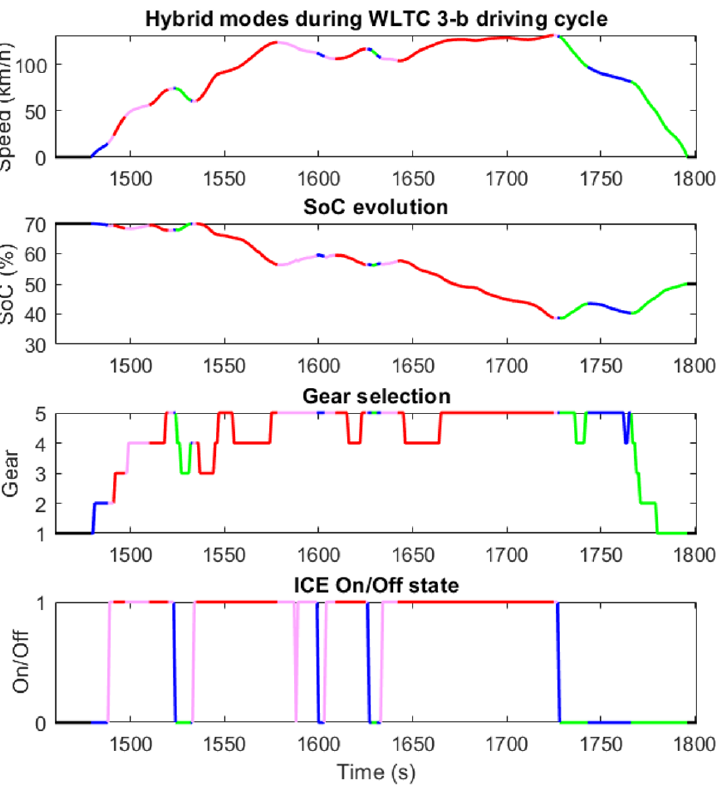
Figure 7. Optimal control results. Black: full stop, blue: Full electric mode; Red: Boost mode; Green: Regenerative Braking; Magenta: Generation